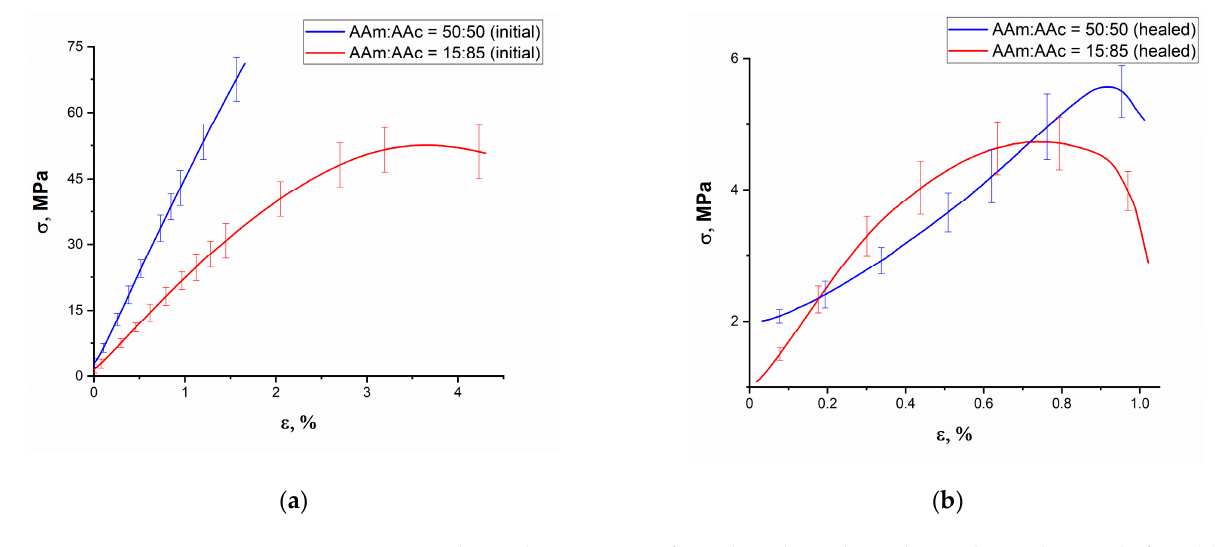
Figure 14. Mechanical properties of acrylamide and acrylic acid copolymers before ( a ) and after ( b ) healing. Table 6. Assessment of healing efficiency in relation to maximum strength.